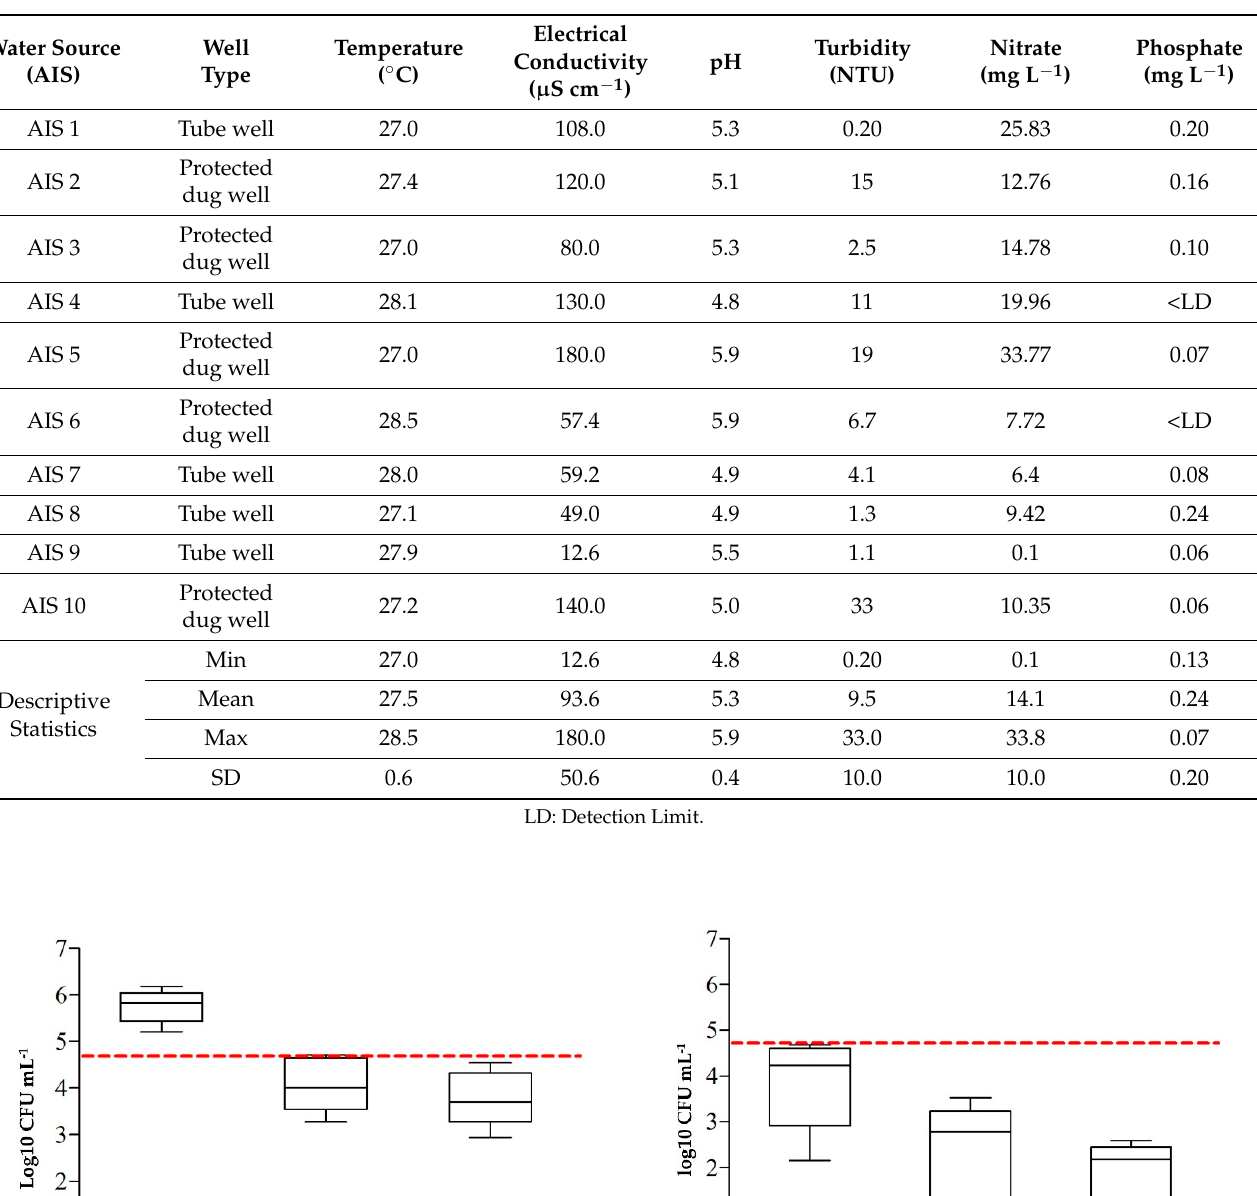
Table 1. Physical–chemical water quality parameters in wells in Porto Velho (RO, Brazil).